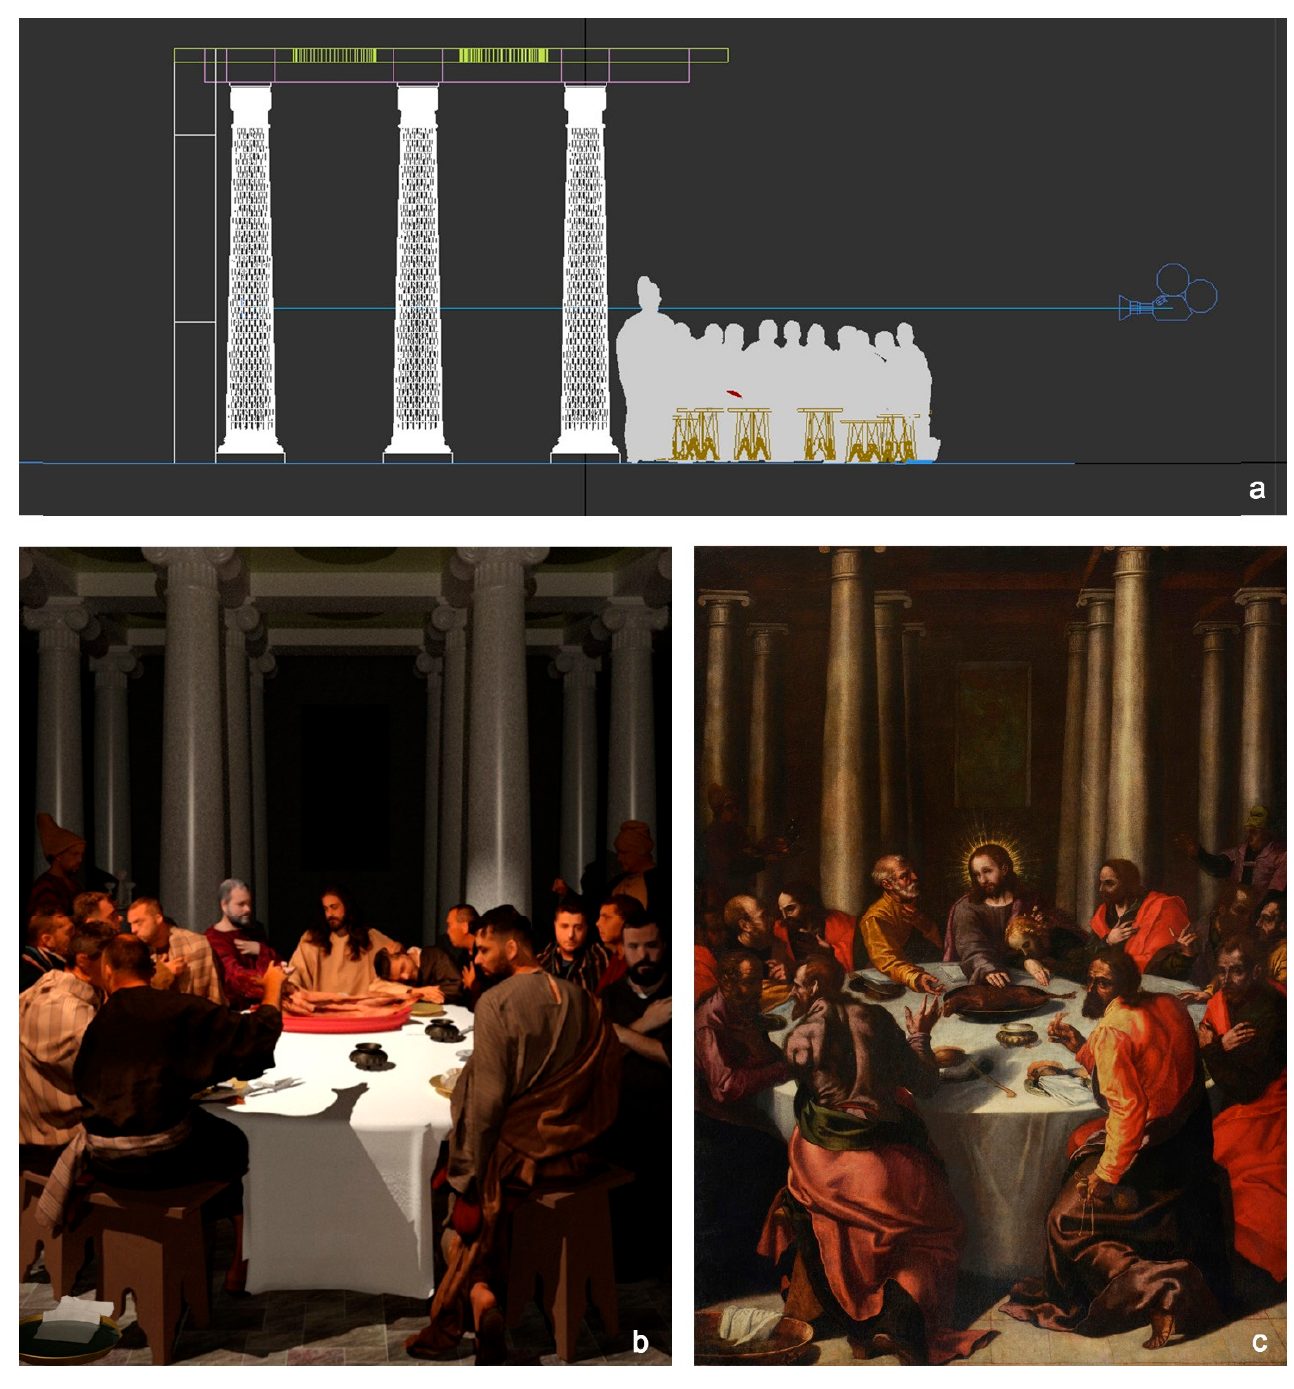
Figure 14. ( a ) Side view of the scene enlargement of the characters and position of the camera at 2.25 m from the ground (25 mm camera); ( b ) image taken from the reconstruction of the virtual model; ( c ) G. Hovic, Last Supper.